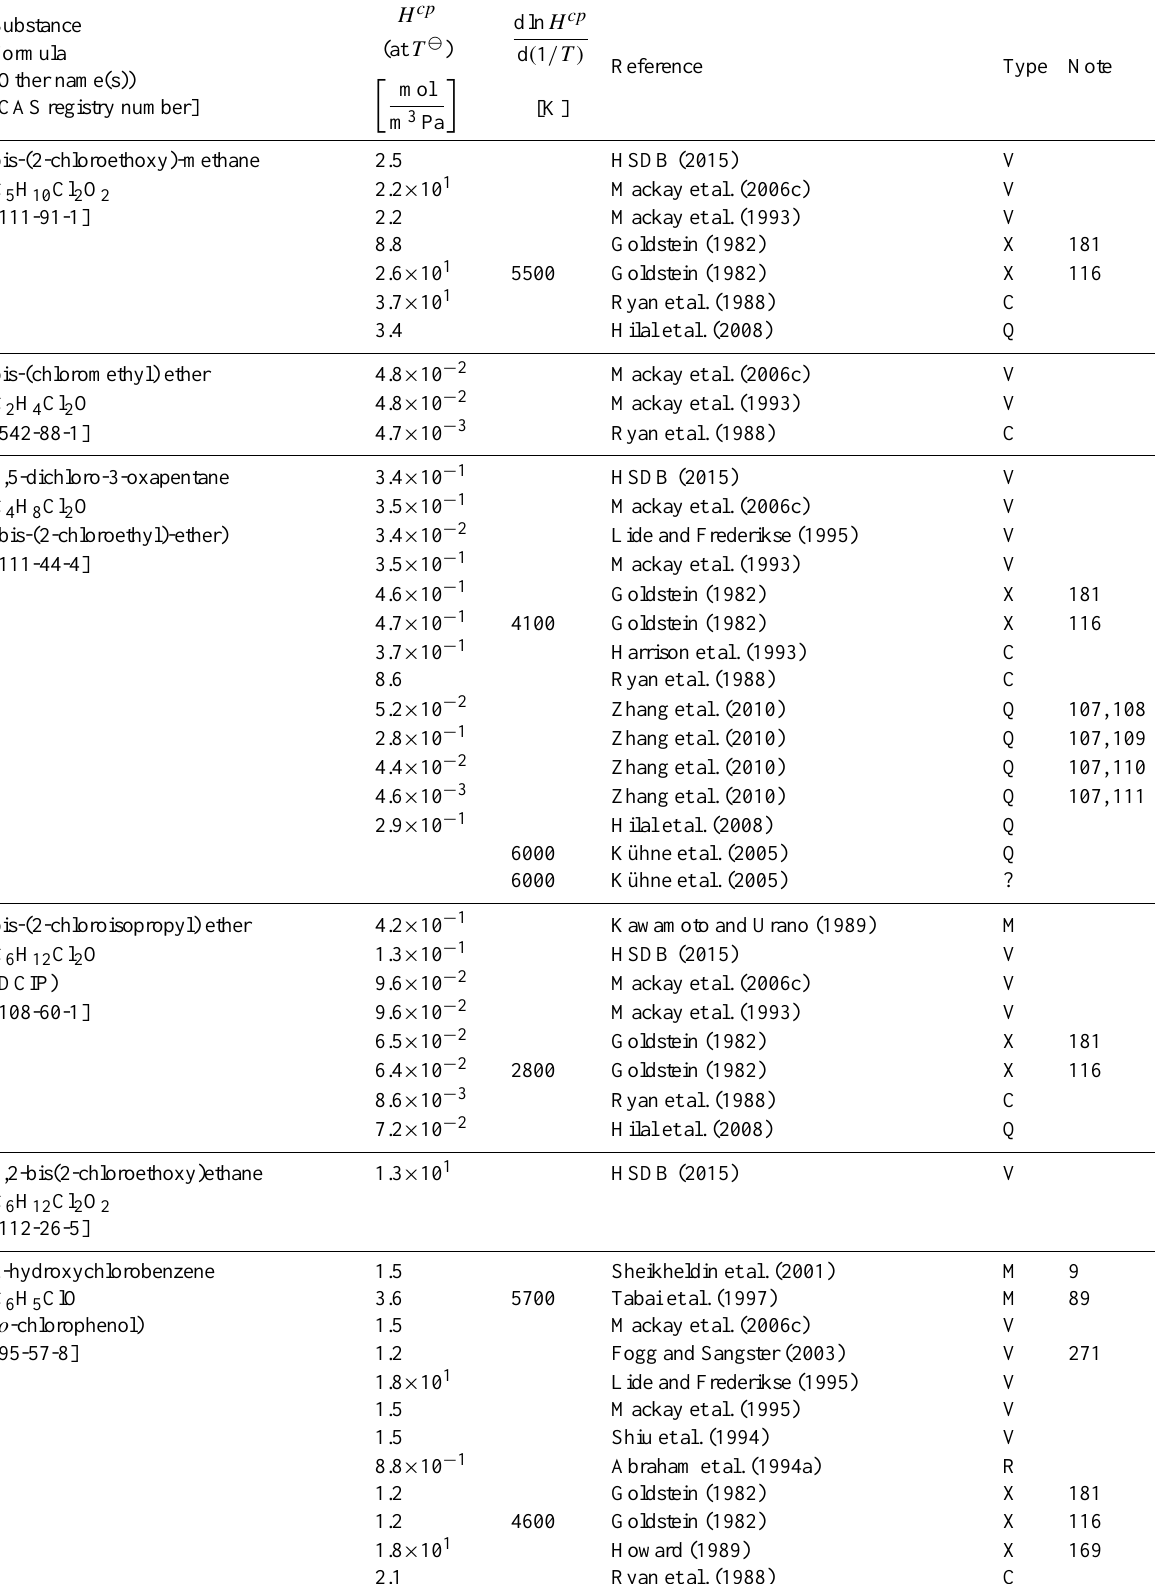
Table 6: Henry’s law constants for water as solvent